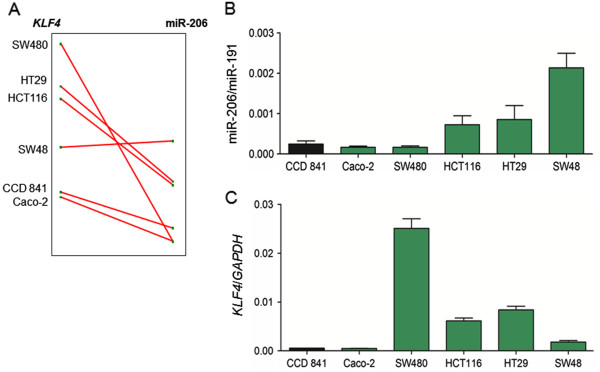
Constitutive expression of miR-206 and KLF4 in human colon cancer cells. (A) Inverse trends for KLF4 and miR-206 in five colon cancer cell lines and non-transformed colonic epithelial CCD841 cells. (B) miR-206/miR-191 and (C) KLF4/GAPDH levels in five colon cancer cell lines (green bars) and CCD841 cells (black bars); data bars indicate mean ± SD, n = 3.